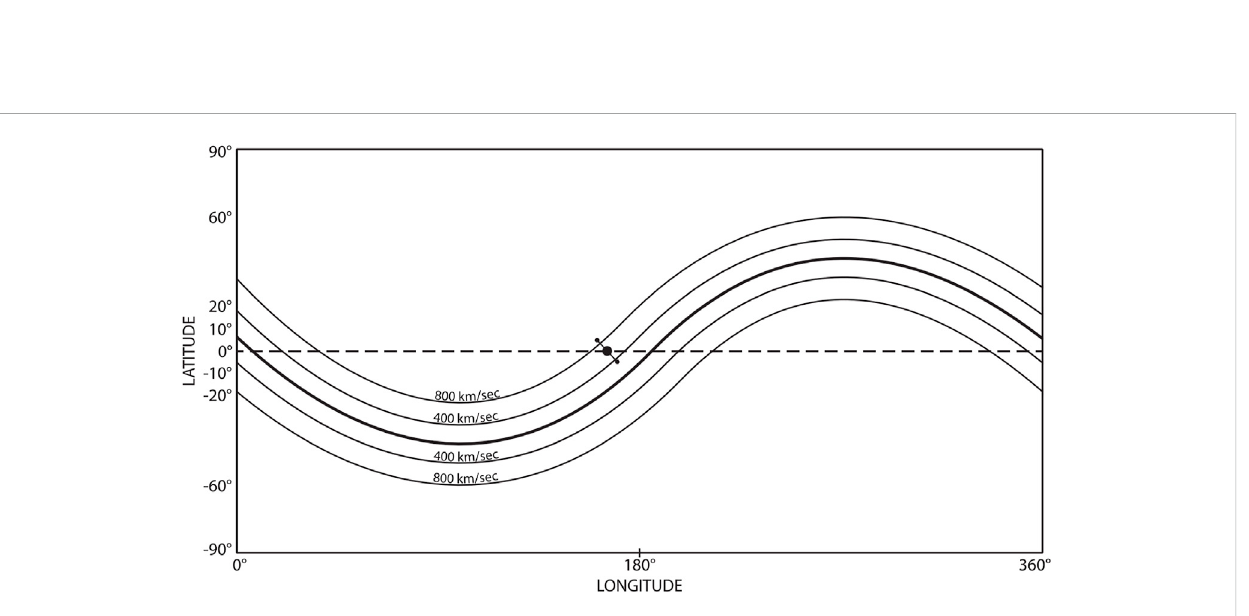
Frontiers in Astronomy and Space